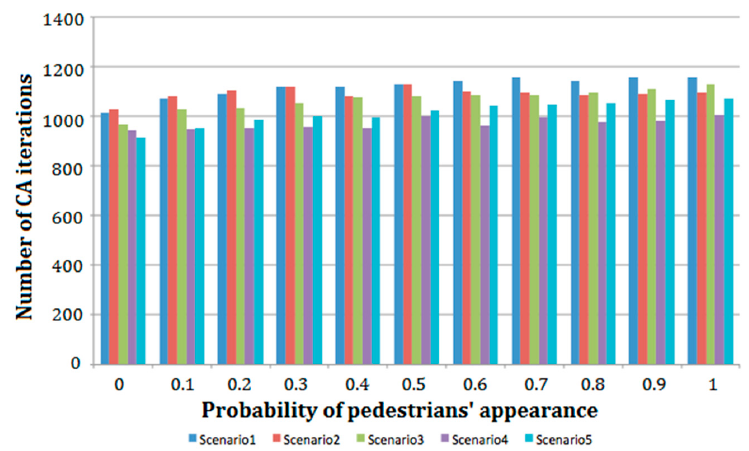
Figure 11. Impact of pedestrian traffic on roundabout capacity as per various traffic scenarios, distance between vehicles = 2. Specified speeds: max car speed = 5, truck speed = 2.